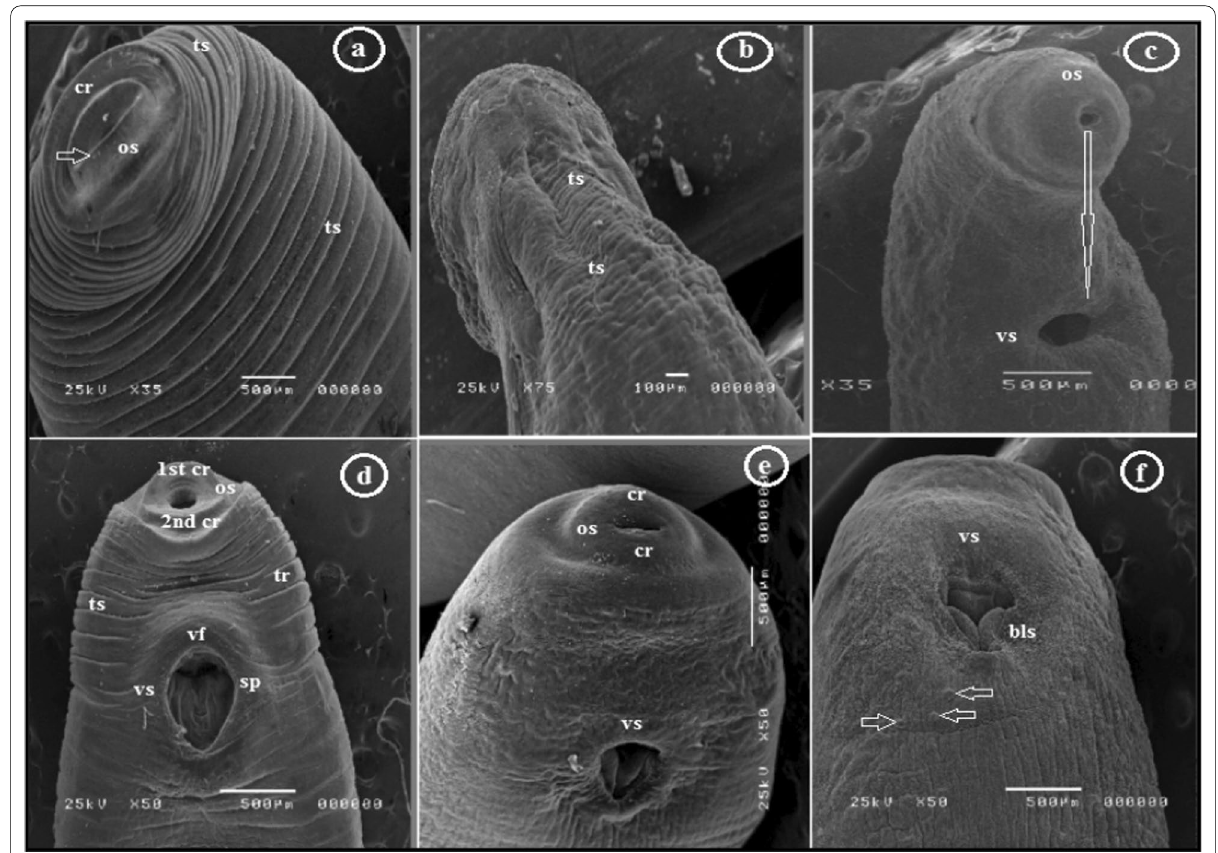
Fig. 2 SEM micrograph of C. phalacrocoracis ; a , b A control unexposed worm exhibited distinct circular collar‑like rings (1st and 2nd cr), oral sucker (os), transverse striation (ts) c , d Exposed worms to V. alternifolia extract dorsal and ventral view exhibited ill distinct transverse striation (tr).; disappeared of ventral transverse striation, dislocated suckers (os‑vs with arrow). e – f Exposed worms to M. piperita extract; ventral view of worm exhibited edematous tegument with completely disappeared (tr) on the lateral sides, ejection of numerus blebs (bls) around the vs